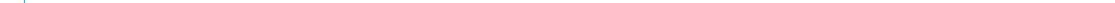
Figure 1: Historical development of humanised mouse strains. The first major advancement was the discovery of a mutation in the Prkdc gene that led to development of SCID mice. The second was the development of NOD.CB17- Prkdc scid /J (NOD scid ) mice, generated by back- crossing mice with the Prkdc scid mutation to mice on the NOD (non-obese diabetic) background. The introduction of a targeted mutation in the locus of the interleukin-2 receptor (IL-2R) γ-chain led to the development of the NOD.Cg- Prkdc scid Il2rg tm1Wjl /SzJ (NSG) mice, which represents the most widely used host strain so far. Further discoveries, took into account the importance of cytokines and growth factors in supporting HSC development, which led to the development of “next-generation” humanised mouse strains, such as MISTRG